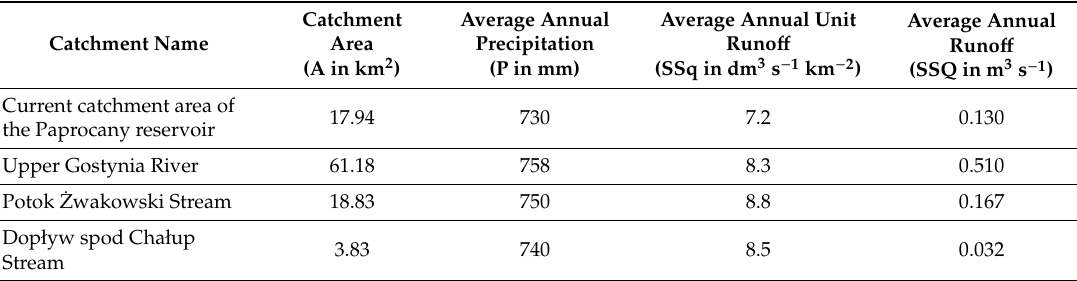
Table 6. Basic parameters of catchments